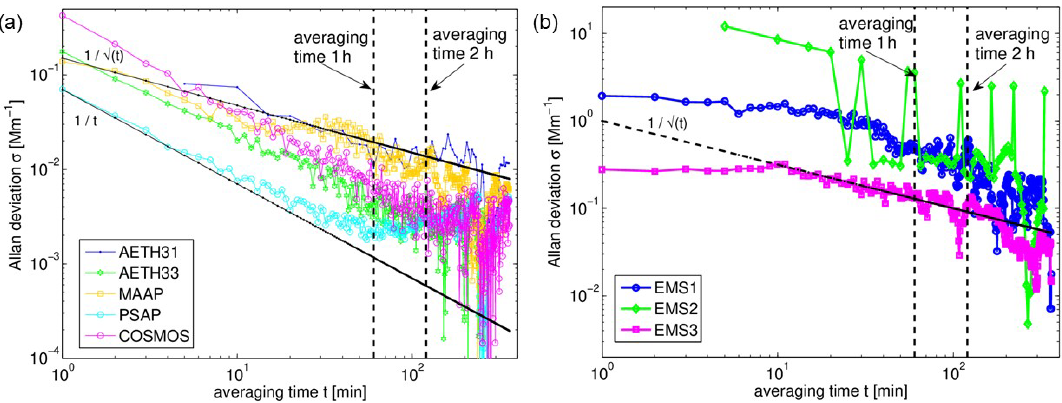
Figure 1. Allan deviation of aerosol absorption σ AP , 637nm measured with (a) the filter-based instruments and with (b) the EMS technique. Averaging times between 1min and 6h are shown in x axis. The black lines with slope − 0 . 5 in (a, b) demonstrate white noise, and in (a) noise with slope − 1 . 0 is added to guide the eye due to better fit with some instruments. Averaging times until 1h (marked with black dashed line) improve signal to noise in all instruments but averaging 2h or more (marked with the second black dashed line) does not always lead to improvement. Table 3. Average ± standard deviation and median absorption coefficient σ AP , 635nm measured with different